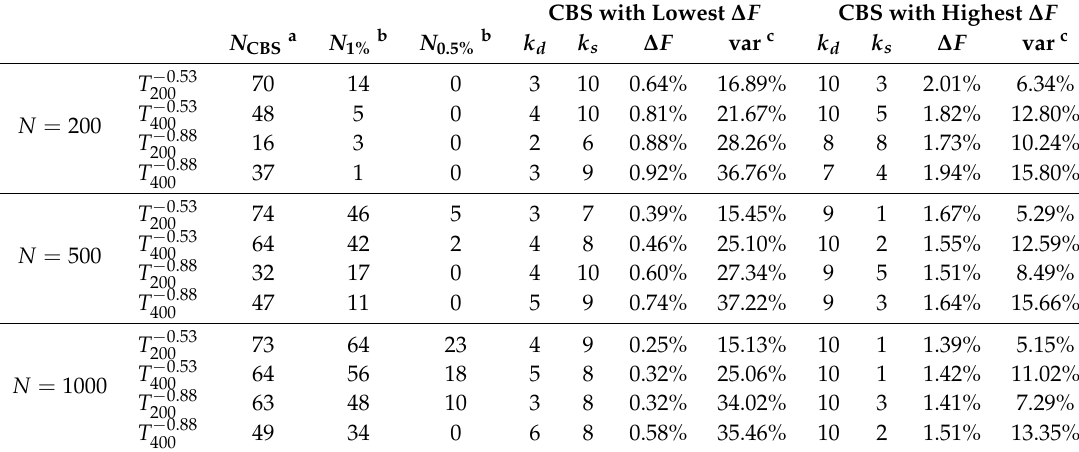
Table 2. Competitive breeding schemes (CBSs) after 100